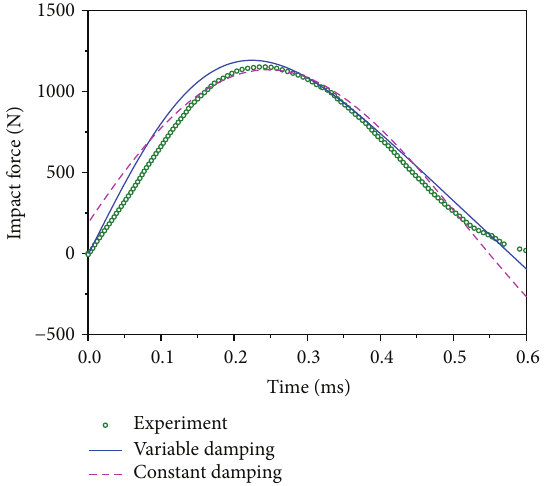
Figure 5: Comparison of pounding force time histories between numerical results and experimental results.